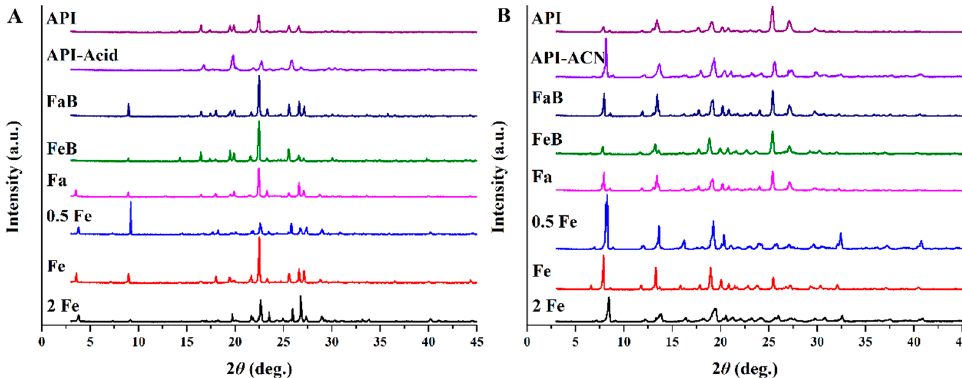
Figure 1. X-rays diffractogram of different samples. ( A ): Rivaroxaban; ( B ): Drug-A. (API-Acid/API-ACN, FaB, FeB, Fa, 0.5 Fe, Fe, and 2 Fe indicate that precipitate comes from the medium of organic solvent, FaSSIF buffer, FeSSIF buffer, FaSSIF, 0.5 × FeSSIF, FeSSIF, and 2 × FeSSIF, respectively).